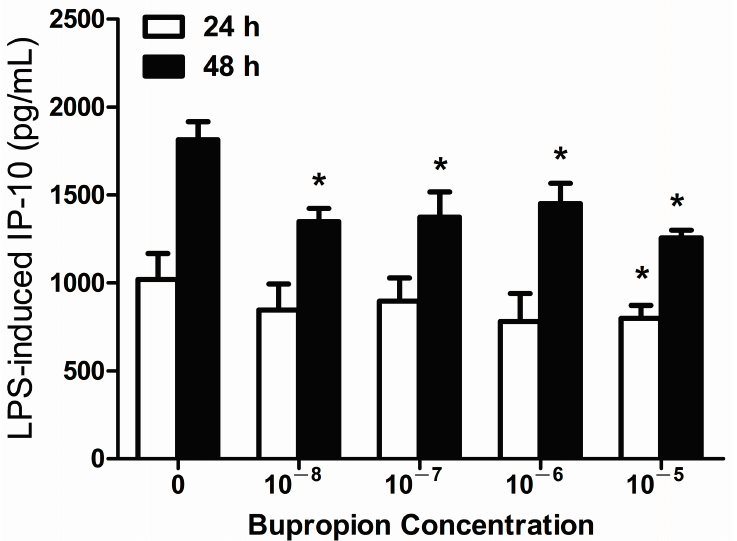
Figure 3. Bupropion suppressed LPS-induced IP-10 expression in THP-1 cells at 24 h (10 − 5 M) and 48 h (10 − 8 –10 − 5 M) after LPS (0.2 µg/mL) stimulation. * p < 0.05 compared with the control (LPS-untreated